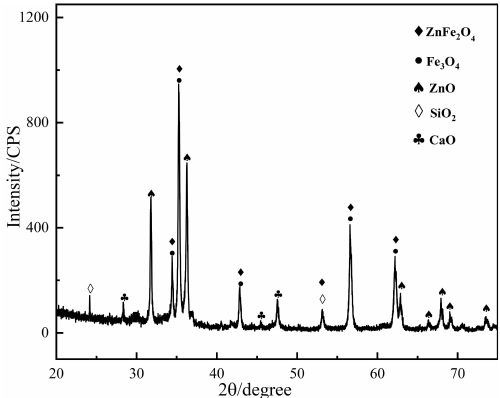
Figure 1. XRD pattern of the EAFD.